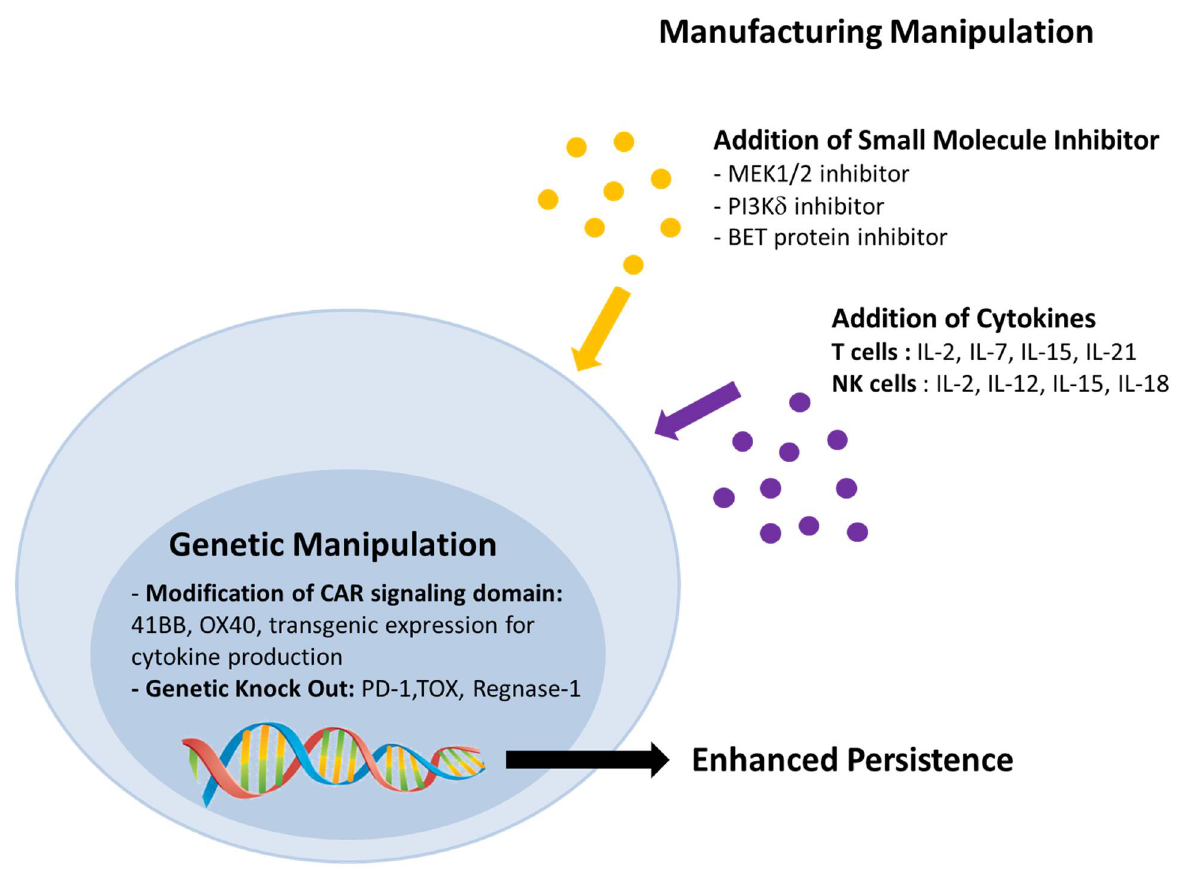
Figure 2. Various approaches to improve the persistence and therapeutic efficacy of adoptive cellular therapy.